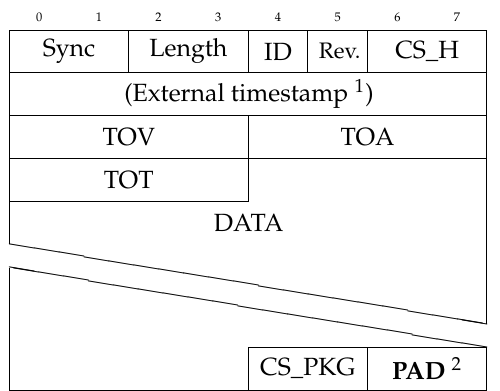
Figure 5. A sensor data envelope. To assign timestamps to sensor message packages, sensor data can be wrapped in this format. 1 An external timestamp can be added when the sensor data is transferred to an external computer. 2 The PAD bytes are zero to three extra padding bytes required by the queueing method described in Section